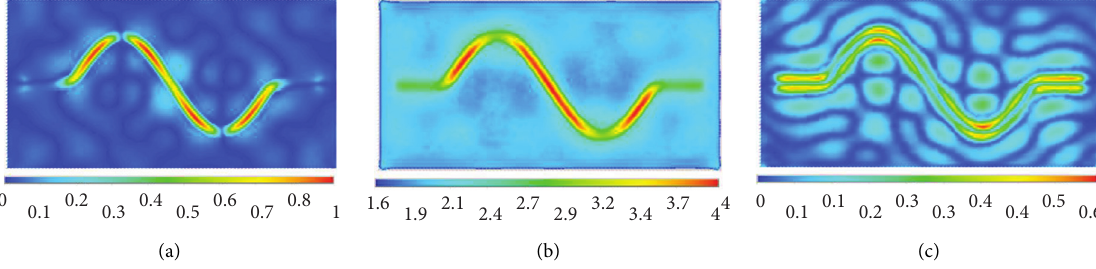
Figure 49: SH wave incident ( C